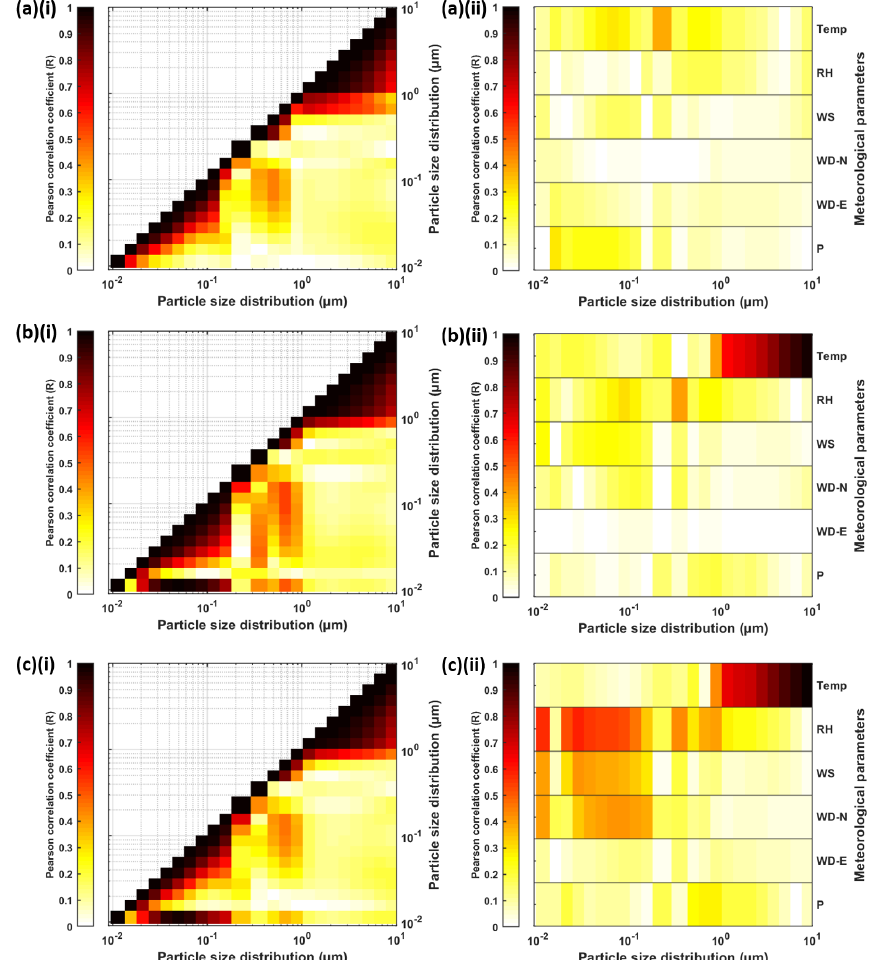
Figure 7. Matrix plots showing the Pearson correlation coefficient ( R ) of particle size distribution of (a) 5min, (b) hourly and (c) daily averaging with (i) particle size distribution itself and (ii) meteorological parameters. Darker colour represents a higher